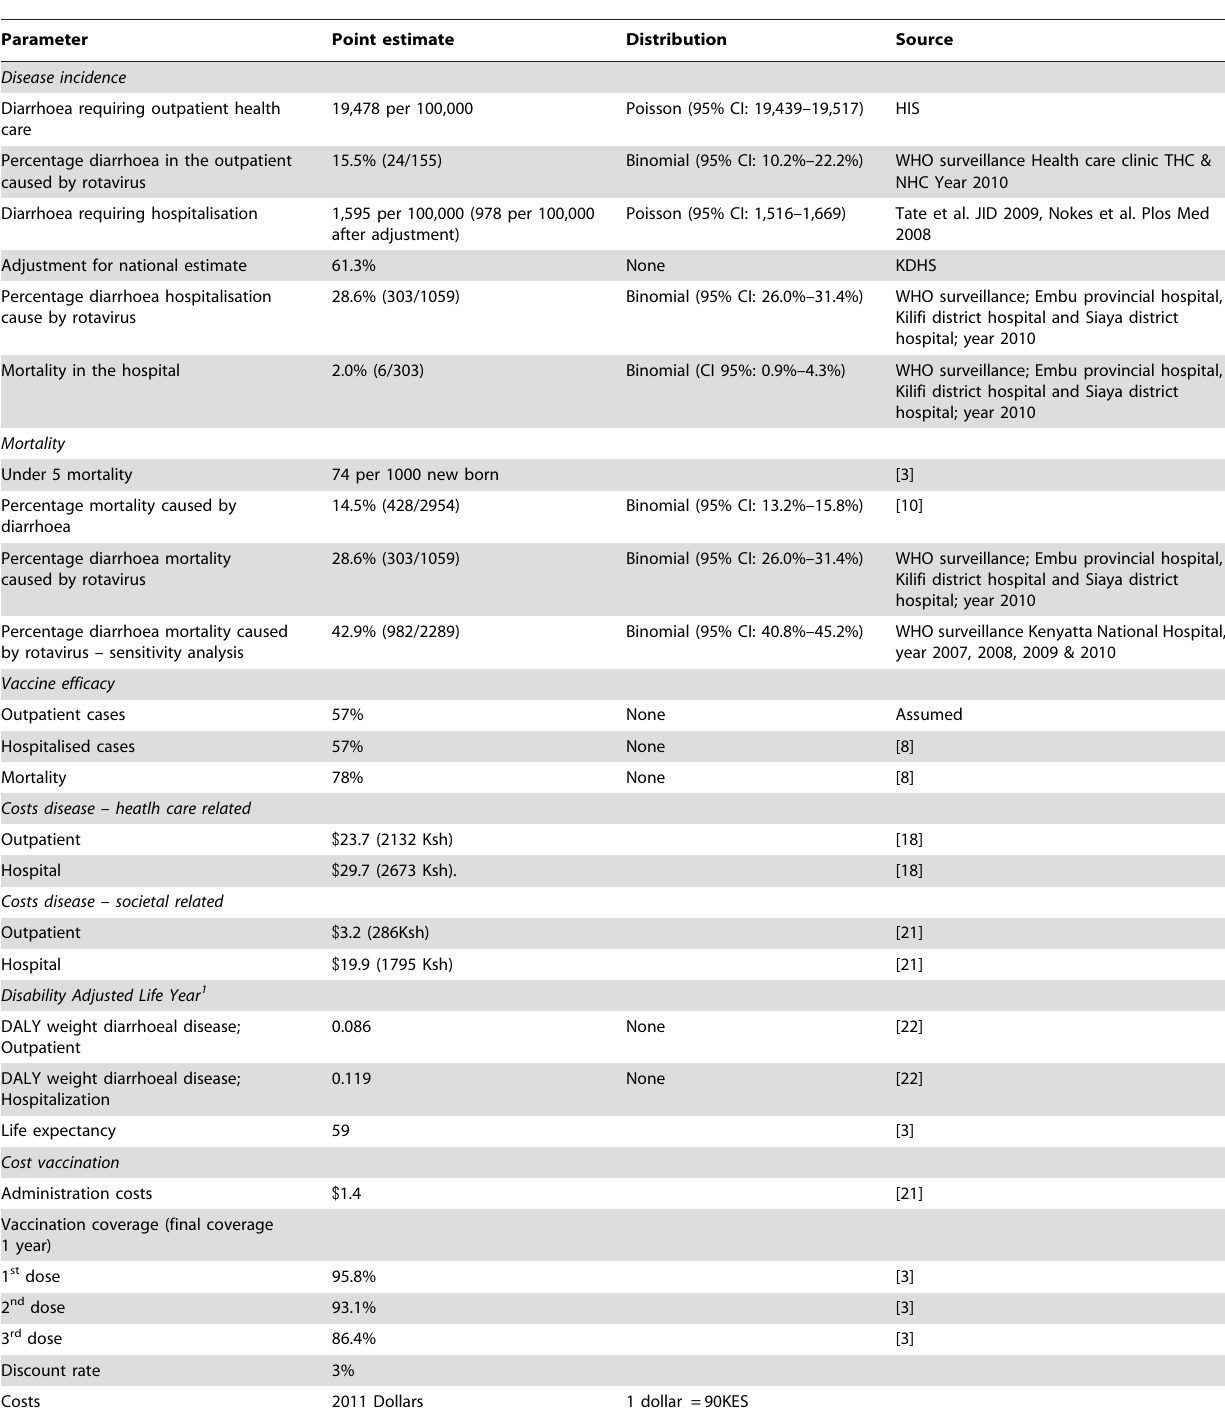
Table 2. Overview assumptions cost effectiveness model in the base